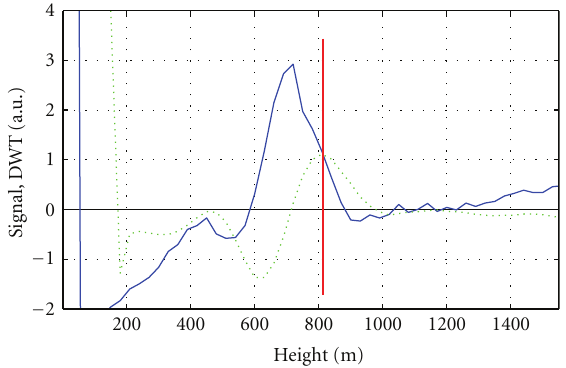
Figure 2: The logarithmic Range-Corrected Signal (blue) and its Discrete Wavelet Transform (green) of the profile around 9:00 UTC. The DWT is calculated with a Haar function of 150 m width. The red line is set at the height corresponding to the first maximum of the DWT exceeding the threshold of 0.5 and represents the estimate of the PBL height at that moment. This threshold is the only parameter to be tuned in the wavelet